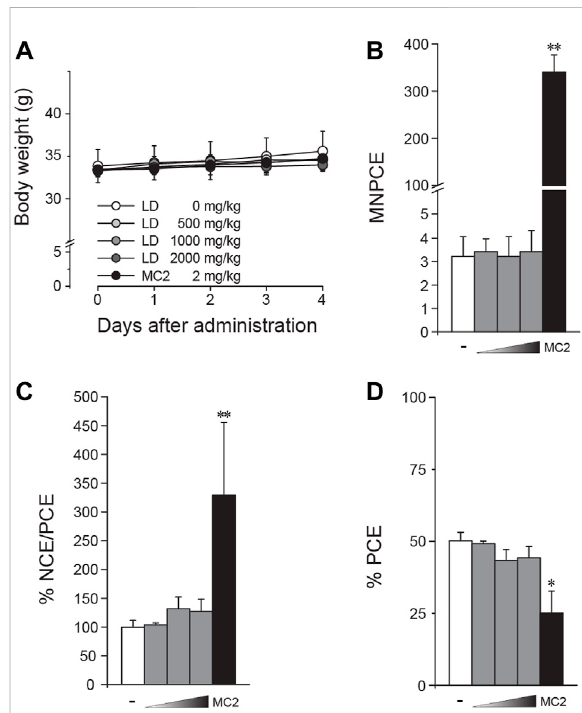
FIGURE 5 Absence of in vivo clastogenicity in lac dye. Eight-week-old male mice were treated with lac dye (LD) for 3 days, and the number of micronucleus-containing polychromatic erythrocytes (MNPCEs) from bone marrow cells isolated from the femora was counted for assessment of clastogenicity. (A) Mice treated with LD did not show differences in body weight change compared to the vehicle control group. LD did not cause an increase in (B) MNPCE, (C) % NCE/PCE, and (D) % PCE compared to the vehicle control group, while the positive control induced a signi fi cant change. White bars, vehicle control; gray bars, lac dye (500,1000,and2000 mg/kgfromtheleft);andblackbars,positive controls (MC2, 2 mg/kg mitomycin) (C) . Negative signs indicate thevehiclecontrol,andright-angledtriangleswithgradientshade, increasing doses of LD. * p < 0.05 by the Kruskal – Wallis test, followed by post hoc Tukey ’ s HSD multiple comparison